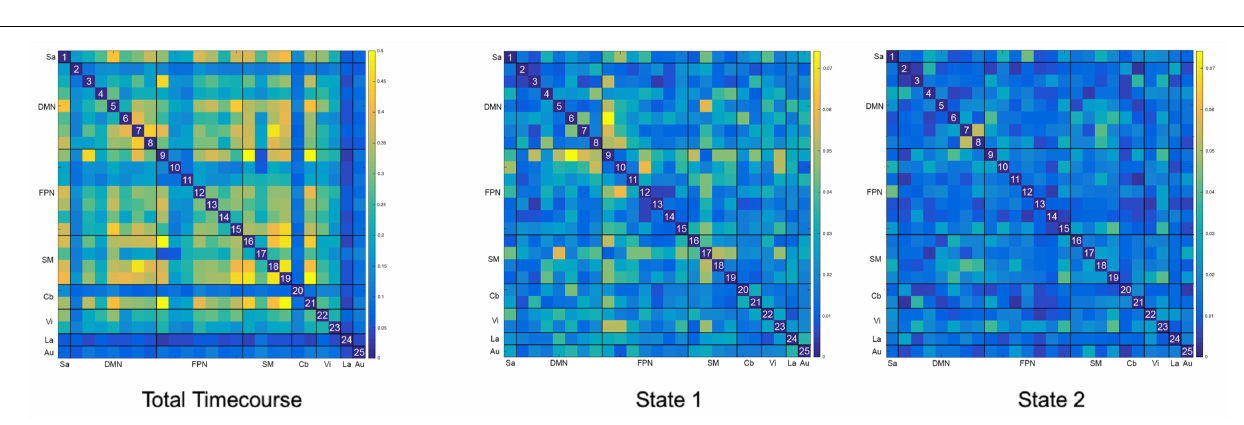
FIGURE 4 | Between-Subject Variance for Static and Dynamic Functional Connectivity Matrices. The variance seen with overall static resting state functional connectivity is an order of magnitude higher ( µ = 0.204) than the variance seen with both dynamic resting states ( µ = 0.022 and µ = 0.016). Please note that the color scale for the total timecourse (0–0.5) is different than for the dynamic states (0–0.75) in order to accommodate this significant